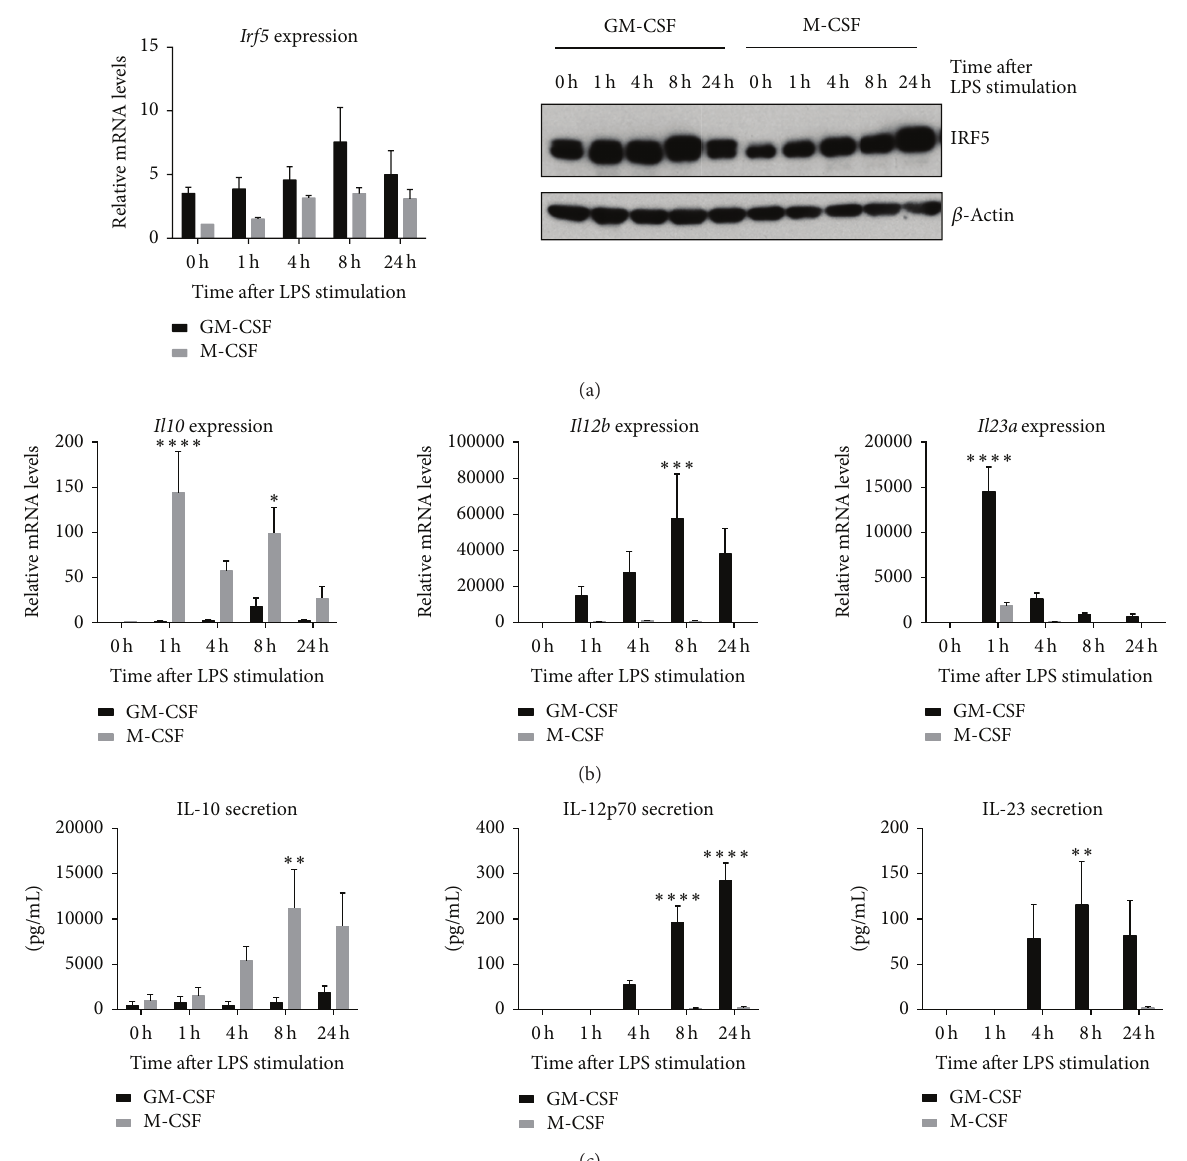
Figure 1: IRF5 levels and cytokine response of in vitro differentiated macrophages. BMDMs were differentiated with GM-CSF (20ng/mL) or M-CSF (100ng/mL) for eight days. All cells were challenged with LPS for the indicated time periods. (a) Transcript levels were measured with real-time PCR. Error bars represent the standard error for 𝑛 = 6 . Protein levels of IRF5 and 𝛽 -actin were determined by western blot. Experiment is representative for three independent experiments. (b) and (c) At each time point RNA (top panel) and supernatants (bottom panel) were collected. Error bars represent the standard error for 𝑛 = 5 . Statistical analysis was performed by 2-way ANOVA and Bonferroni’s multiple comparison. ∗ 𝑃 ≤ 0.05 ; ∗∗ 𝑃 ≤ 0.01 ; ∗∗∗ 𝑃 ≤ 0.001 ; ∗∗∗∗ 𝑃 ≤ 0.0001 . MHCII, and CD206 (mannose receptor), respectively, as